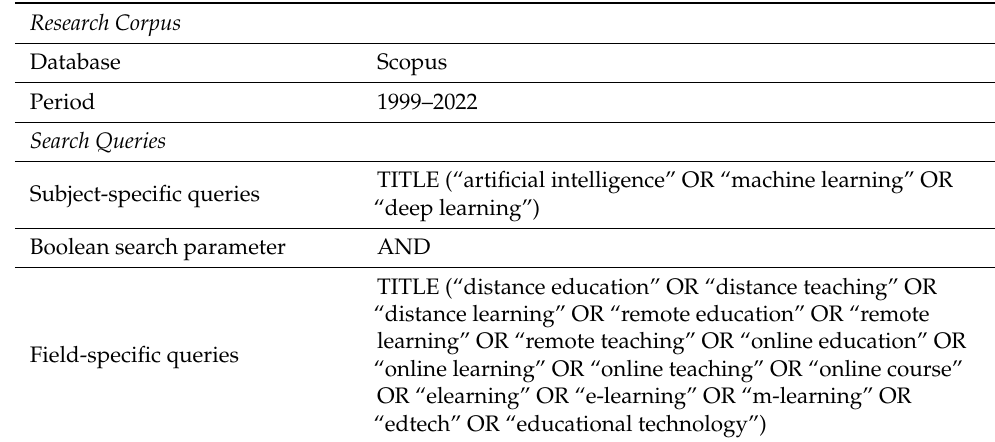
Table 1. Information on the research corpus and search queries adopted for the inclusion criteria.